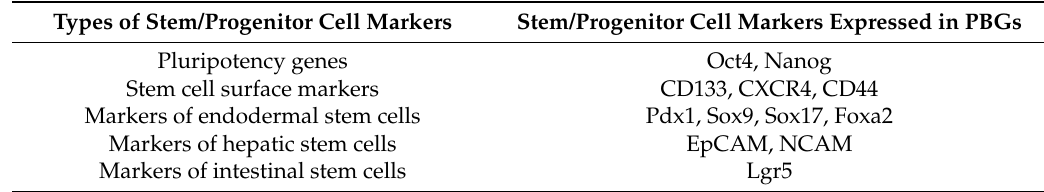
Table 2. Stem/progenitor cell markers expressed in